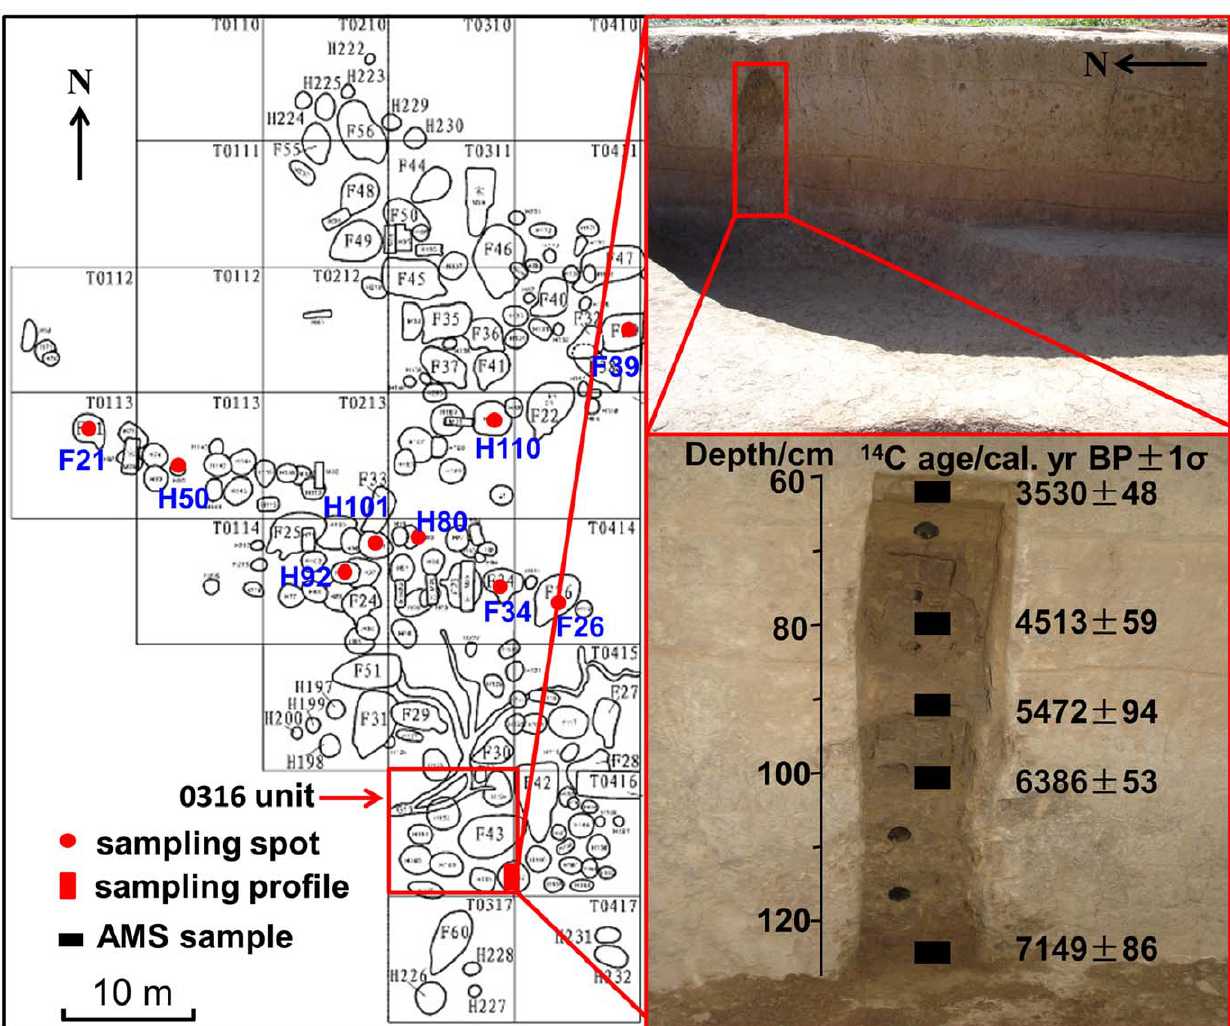
Figure 2. Sampling locations from the Tanghu site. The plan positions of archaeological units is after Xin et al. (2010).